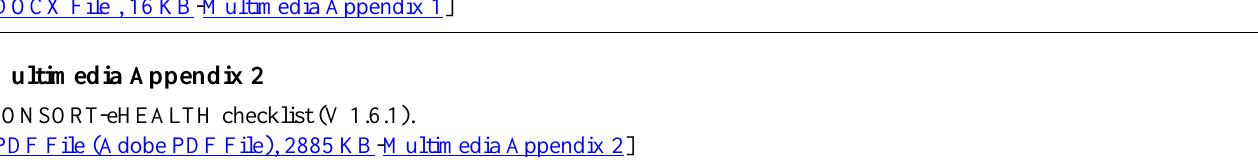
Table illustrating the themes of the program, number of text messages per week and examples of